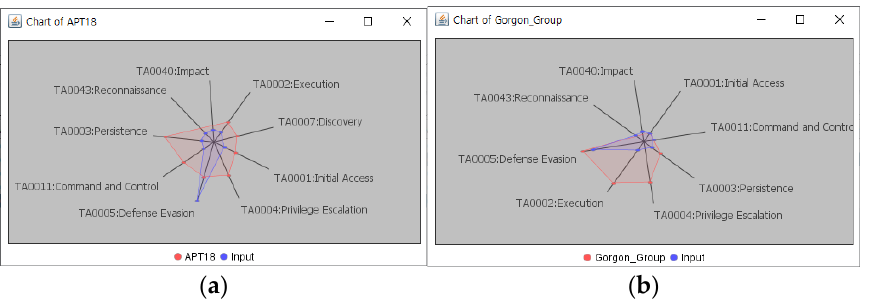
Figure 14. Result of the similarity metric (with one feature weighted more than the others). Figure 15. Tactical visualization of the top-two groups shown in Figure 14. ( a ) APT18 and ( b ) the Gorgon group. Gorgon